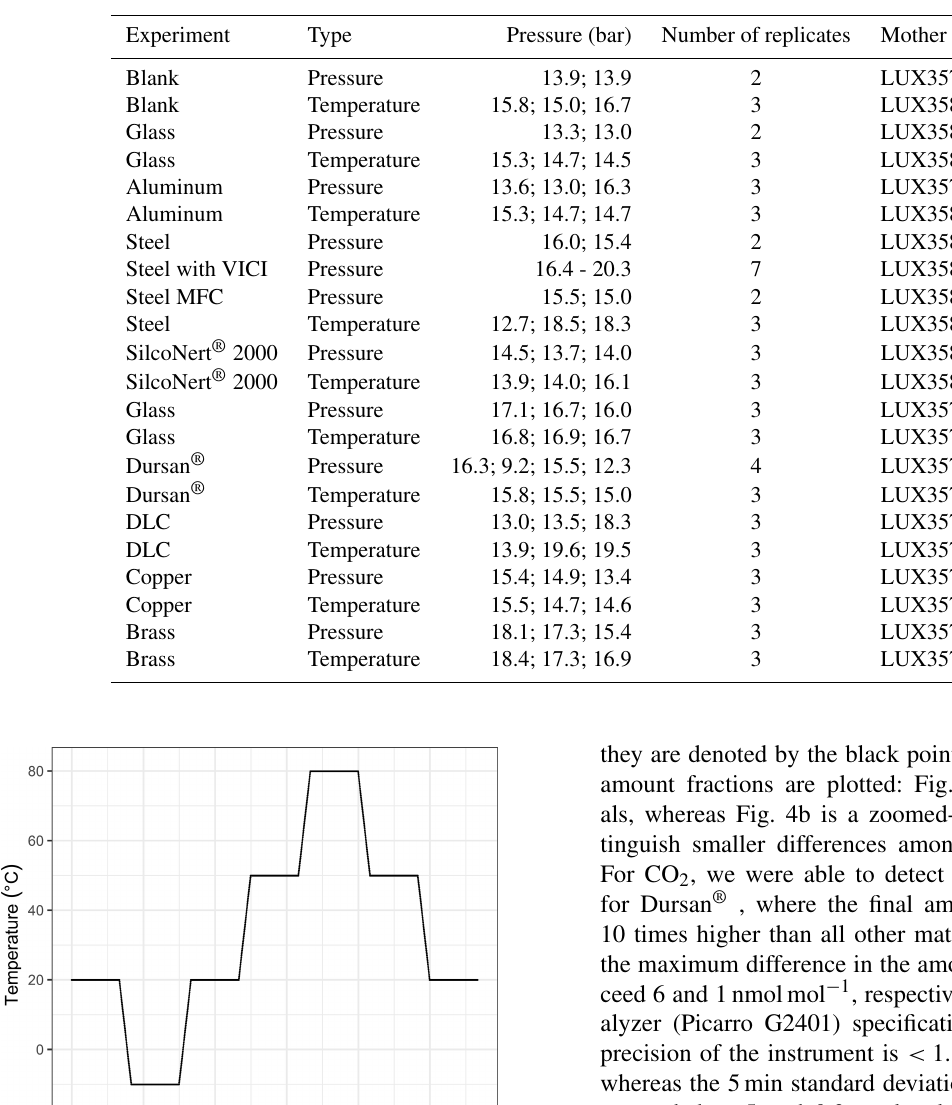
Table 1. An overview of data included in this study. The pressure values indicate the pressure in the small cylinder at the beginning of each replicate run.